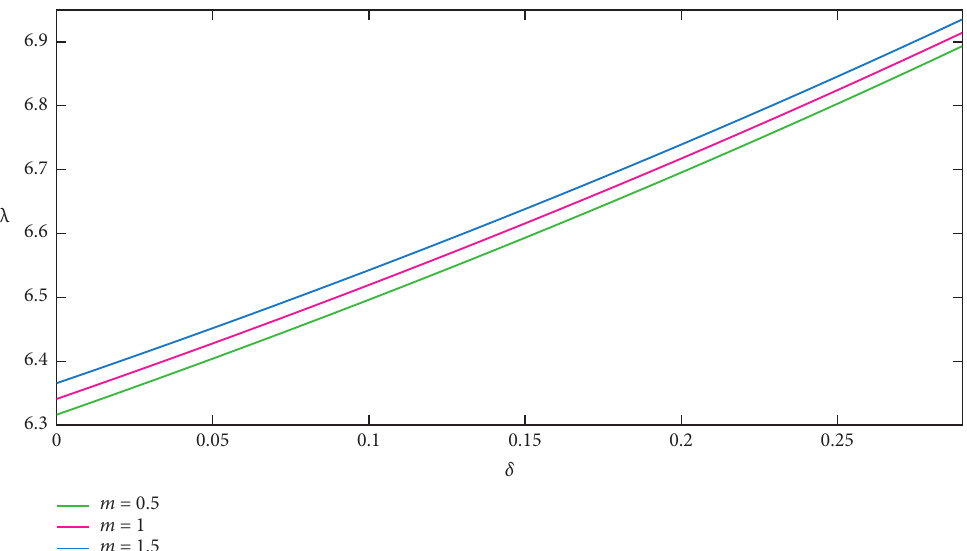
Figure 3: Variation of resistance for the Carreau model for We � 0 . 2 , n � 2 ,L � 1 , and F � 0 . 6.